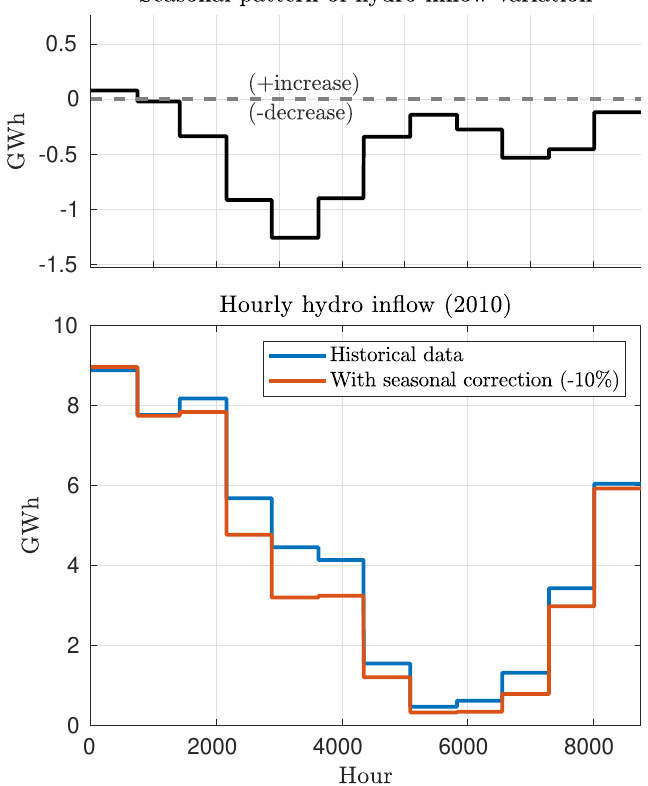
Figure 8. Top : Seasonal variation of hydro inflow, adapted from Reference [20], and computed for a reduction of 10% of the annual hydro inflow observed in Spain in 2010. Bottom : Hourly hydro inflow in Spain for 2010, and modified assuming a variation of − 10% in the annual hydro inflow and the seasonal variation (see text for